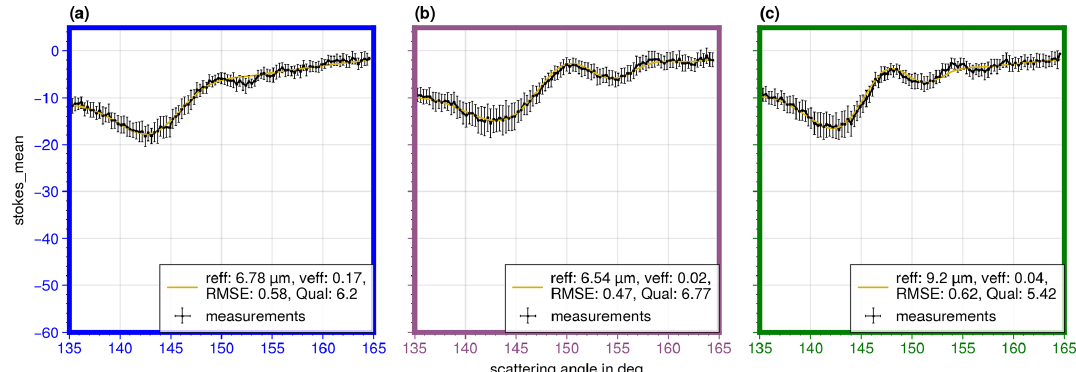
Figure 15. The aggregated polarized radiance measurements of the green channel of the locations shown in Fig. 14 were binned to a 0 . 3 ◦ resolution in the scattering angle (black dots connected by black lines). The error bars represent the standard deviations of all original data points within a 0 . 3 ◦ bin. The yellow lines indicate the best-fitting simulations. The parameters r eff , v eff , RMSE, and Qual of the best-fitting simulations are shown in the boxes in the lower right. For better visual comparison with the aggregated measurements of the first case study, the y axis covers the same range as in Fig. 9.